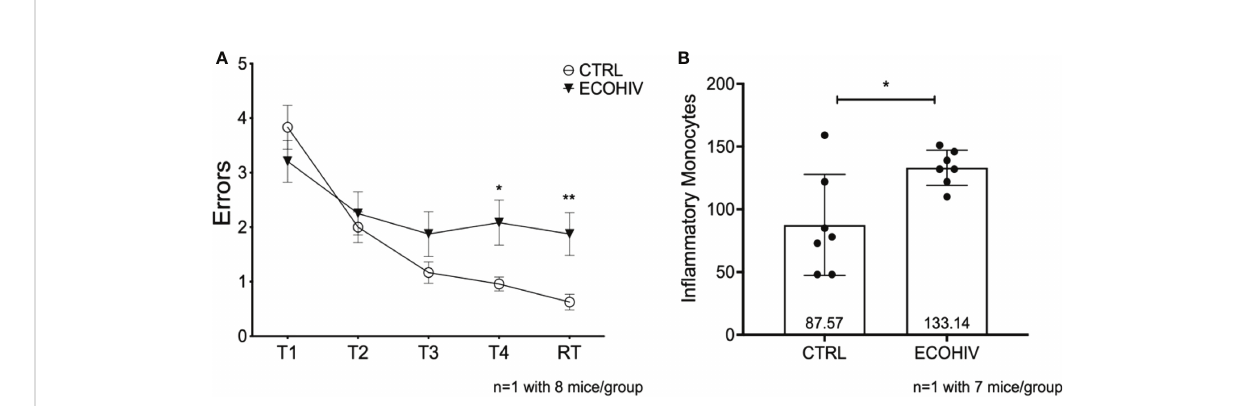
FIGURE 3 Mice are cognitively impaired after two weeks of infection and have signi fi cantly more brain in fl ammatory monocytes. We tested an early timepoint after infection a time in which cognitive impairment is being established. These data are from one independent experiment with eight mice in each group for water maze testing (A) and seven mice in each group for monocyte studies (B) Mice were infected with EcoHIV or injected with a diluent control (PBS). After these two weeks, eight mice in each group performed RAWM testing (A) EcoHIV infected mice, represented as the closed circles, were cognitively impaired as they made signi fi cantly more errors in Trial 4 and the retention trial compared to control mice represented as the open circles (T5 p<0.05, RT p<0.001). These data show that the establishment of EcoHIV-NCI has begun to manifest after two weeks of infection. After which the number of in fl ammatory monocytes were quanti fi ed by fl ow cytometry as previously described. (B) , Data are shown as mean +/- SD. There are signi fi cantly more in fl ammatory monocytes (p<0.05) in the brains of EcoHIV infected mice (133.1 +/- 14.03) compared to control mice (87.57 +/- 40.27) determined by a Student ’ s t-test. *p<0.05;